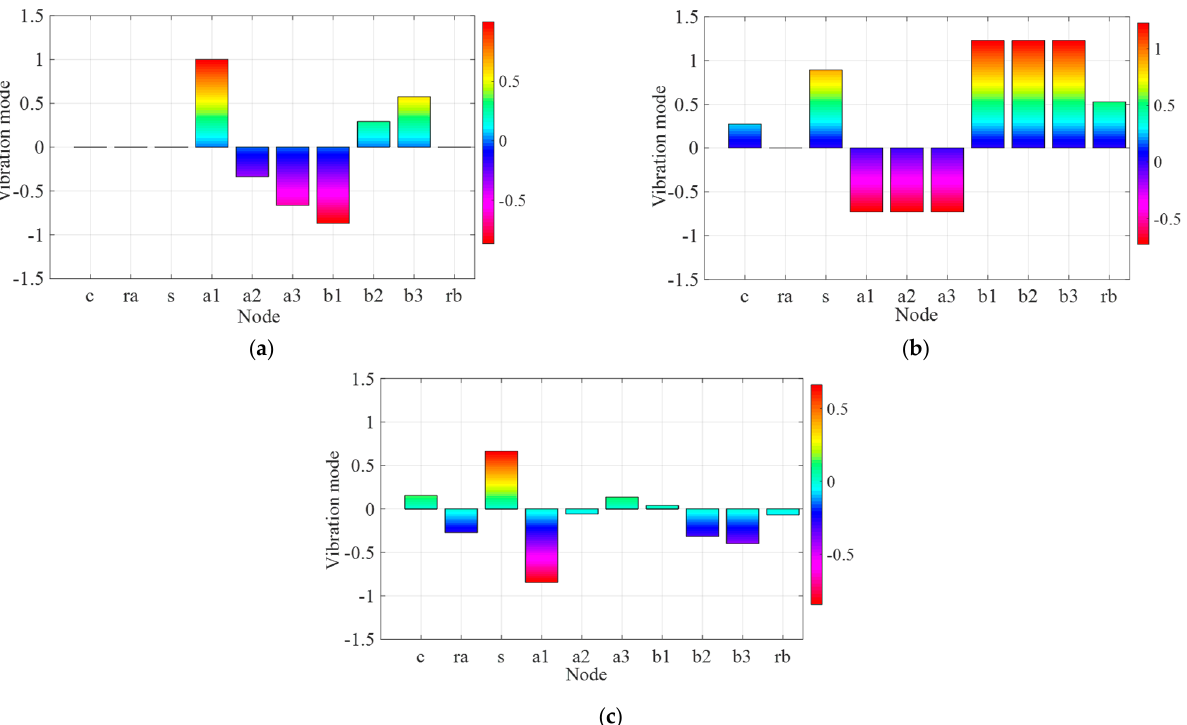
Figure 7. The vibration modes of each order of the composite planetary gear system: ( a ) Planetary wheel vibration; ( b ) Global vibration; ( c ) Coupled vibration.